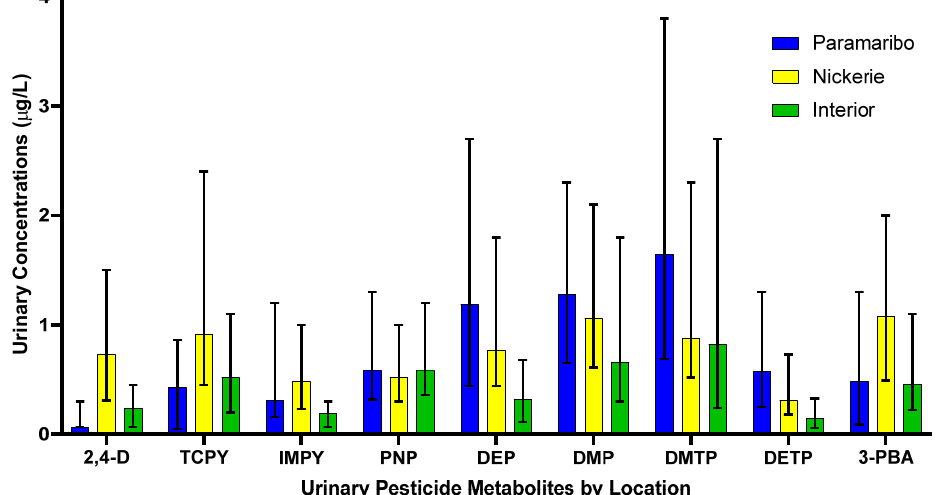
Figure 2. Specific gravity adjusted urinary pesticide metabolite concentrations from pregnant women in Suriname by location. Data is presented as median concentrations with error bars as the interquartile range.